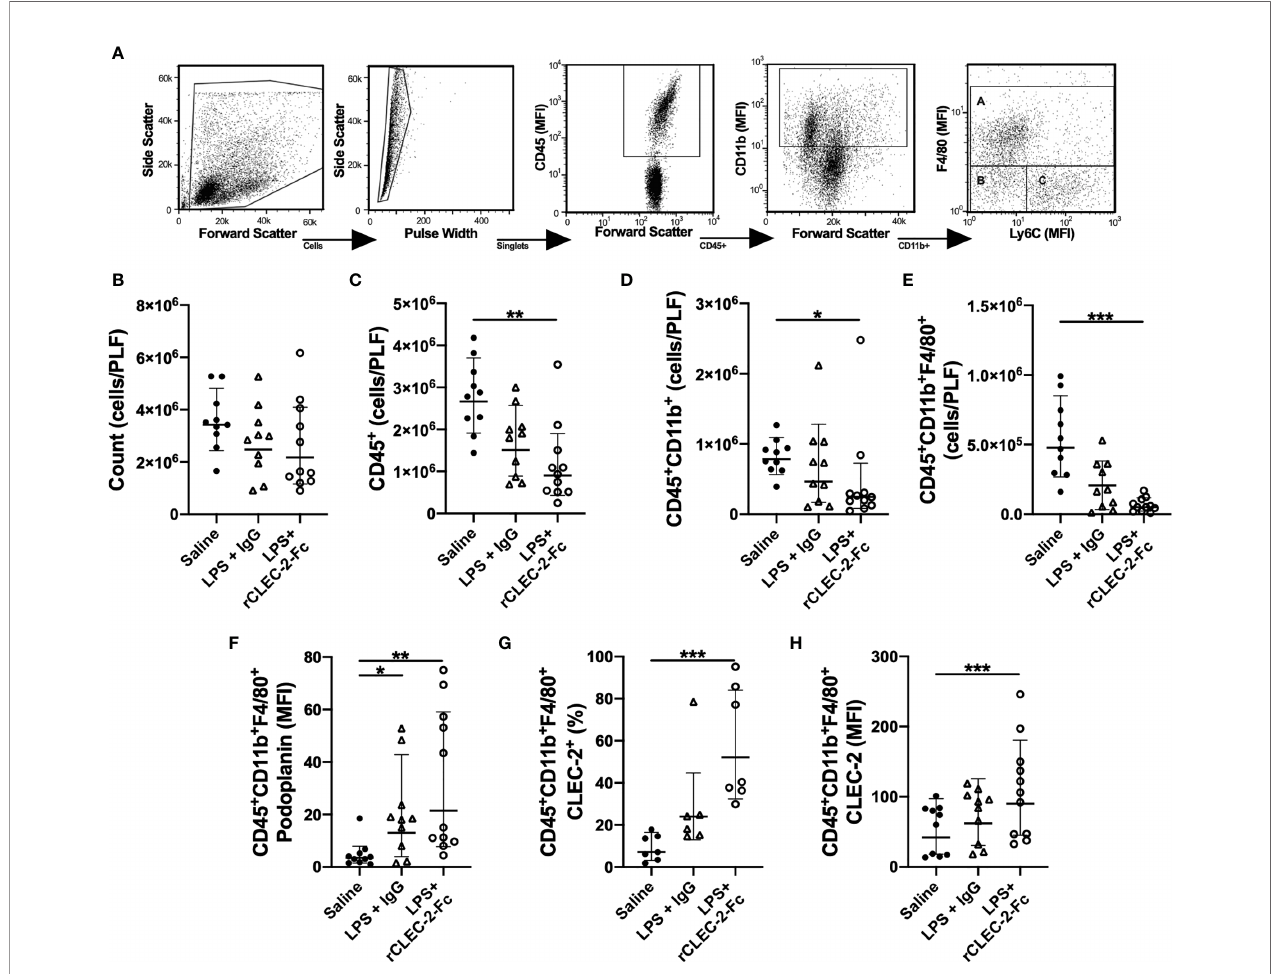
FIGURE 4 | rCLEC-2-Fc decreases macrophage number in the peritoneum following endotoxemia. WT mice were intraperitoneally injected with LPS (10mg/kg) for 18h followed by rCLEC-2-Fc or IgG isotype control (100µg/mouse) for and additional 4h (n=11). Immune cell and platelet in fi ltration in the peritoneal lavage (PLF) were measured using fl ow cytometry. (A) Gating strategy to identify A: macrophages (CD11b + F4/80 + ), B: monocytes (CD11b + Ly6C + ) and C: neutrophils (CD11b + F4/ 80 - Ly6C - ). (B) Total number of cells from the peritoneal lavage, (C) leukocytes (CD45 + ), (D) myeloid cells (CD45 + CD11b + ) and (E) macrophages (CD45 + CD11b + F4/ 80 + ) were measured in the PLF. (F) MFI of podoplanin expressed on the surface of macrophages. (G) Percentage of CLEC-2-positive macrophages and (H) the MFI of CLEC-2 expression on macrophages. The statistical signi fi cance was analyzed using a Kruskal-Wallis multiple comparisons test. * p <0.05, ** p <0.01, *** p